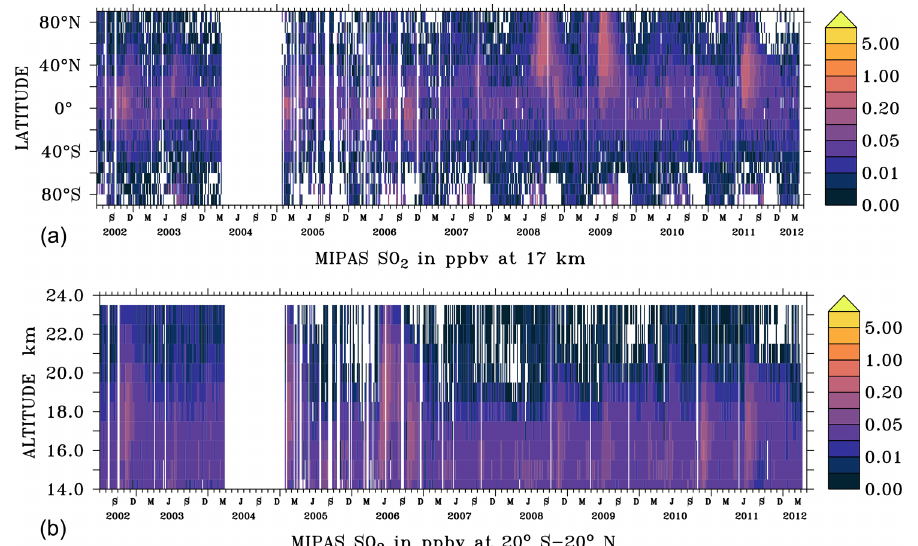
Figure 1. The volume mixing ratios of SO 2 in ppbv as derived from the MIPAS instrument (Höpfner et al., 2015). The dataset spans the period 1 July 2002–8 April 2012 (5d averages). Horizontal distribution at 17km altitude (a) and vertical distribution for tropical regions 20 ◦ S–20 ◦ N (b) . White: no